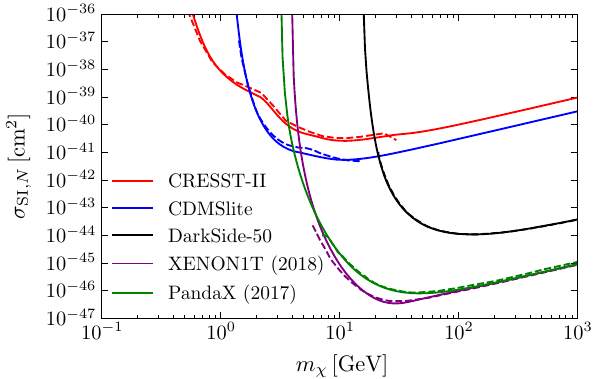
Fig. 13 90%C.L.upper limits on the spin-independent DM-nucleon scattering cross-section from CRESST-II, CDMSlite, DarkSide-50, PandaX-II and XENON1T. The solid curves show the limits obtained using DDCalc ,whilethedashedcurvescorrespond tothelimitsderived by the collaborations [88–91,93]. Note that close to threshold the exclu- sion limits depend sensitively on the detector response and an accurate modeling in DDCalc is very